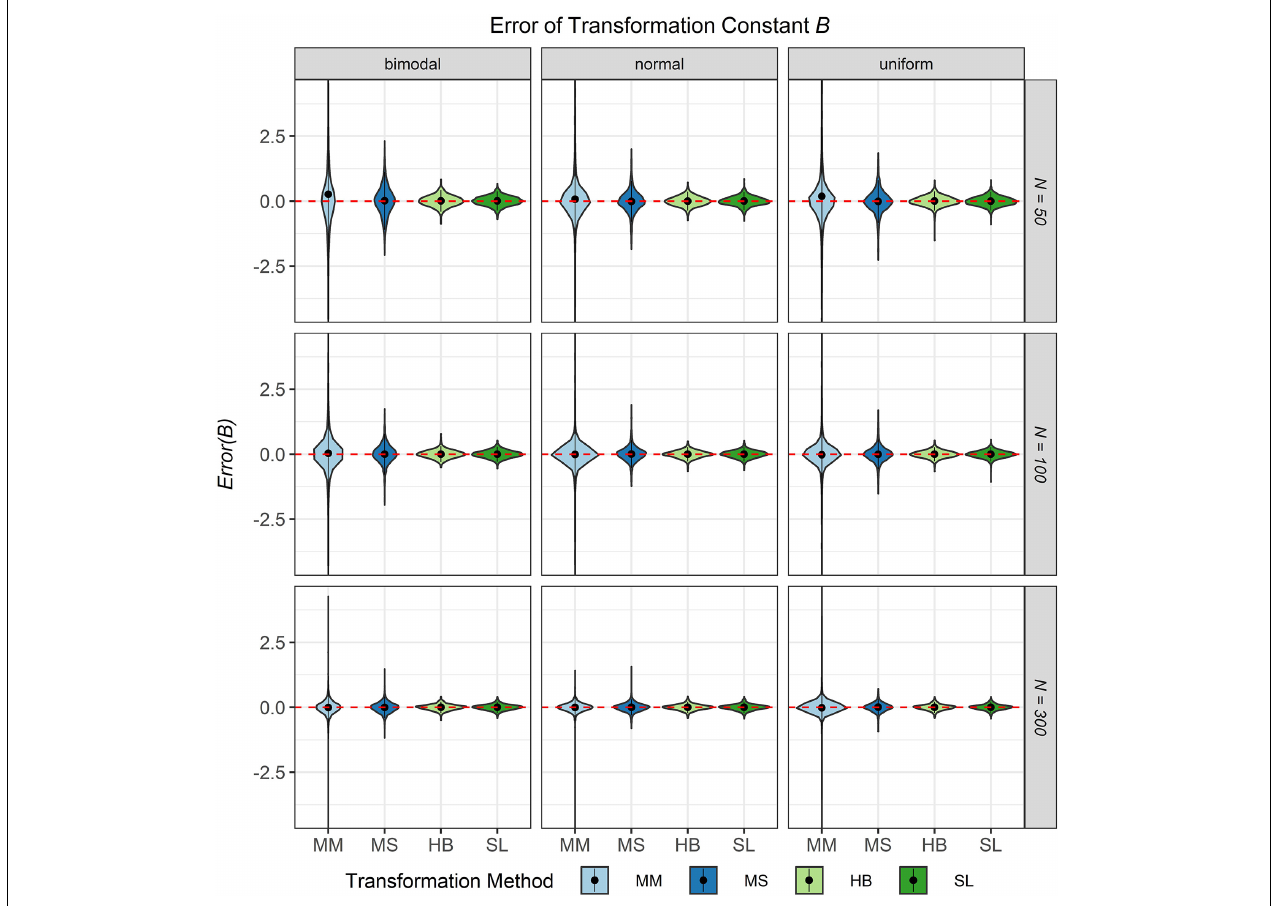
FIGURE 9 | Error of the transformation constant B in the continuous calibration strategy for different sample sizes per test cycle, different common item difficulty distributions, and different scale transformation methods (MM = Mean/Mean, MS = Mean/Sigma, HB = Haebara, SL = Stocking-Lord). The dot in the middle of each violin represents the bias and the width of the violin expresses the frequency of the corresponding